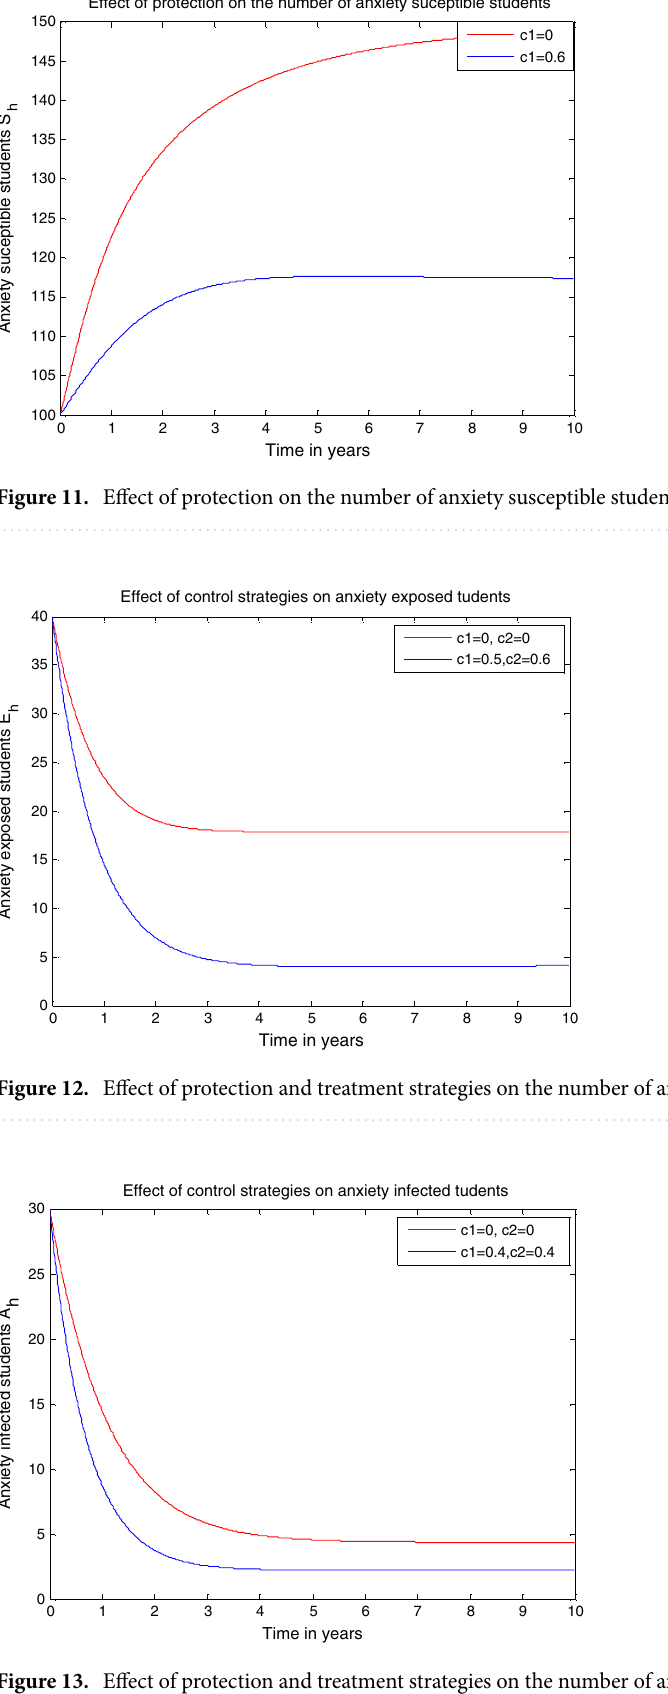
Figure 13. Effect of protection and treatment strategies on the number of anxiety infected students ( A h )